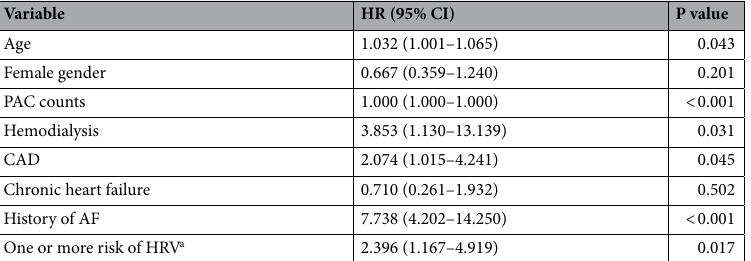
Table 6. Multivariate analysis of the occurrence of atrial fibrillation. PAC, premature atrial contraction; CAD, coronary artery disease; HRV, heart rate variability. a Indicates that at least one of the abnormal HRV parameters (HF, rMSSD, and pNN50) were